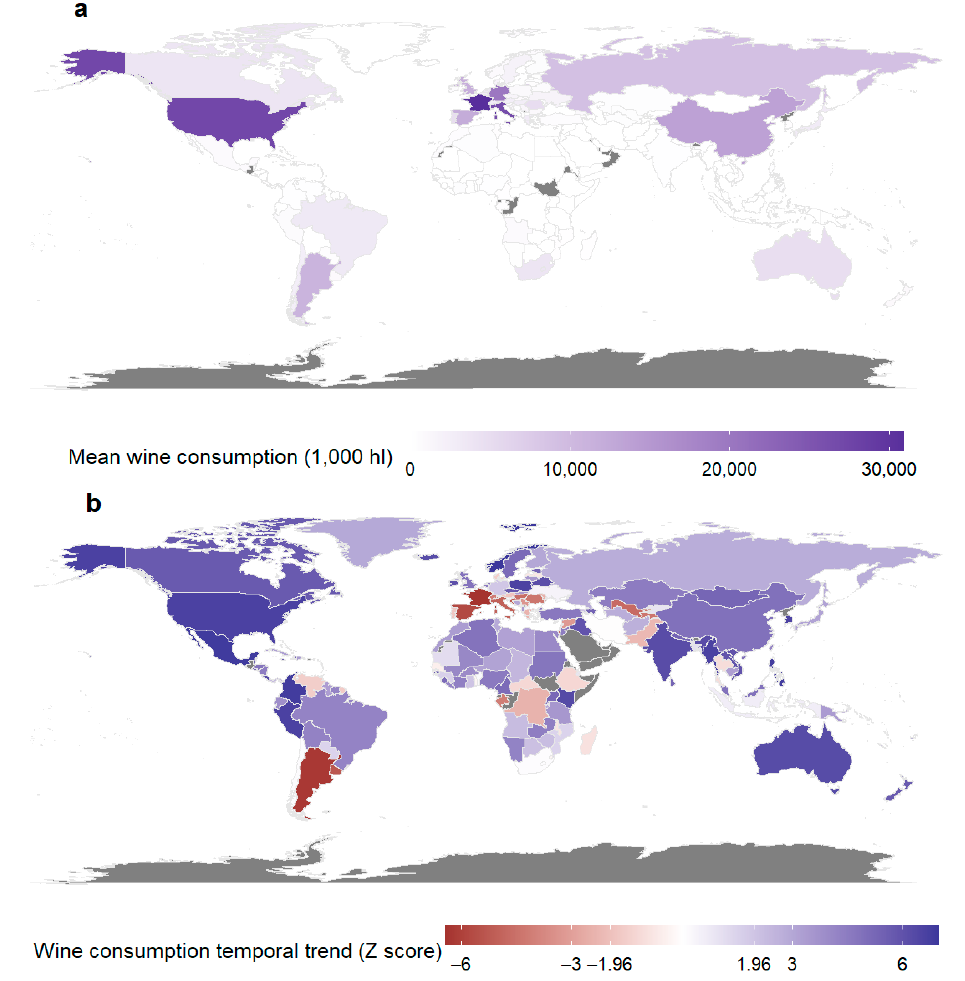
Figure 2. Wine consumption representation for each country, including mean long-term quantities ( a ); and Z-score for each country, signifying the extent of the temporal trend over 27 years ( b ). Countries in grey represent no data.